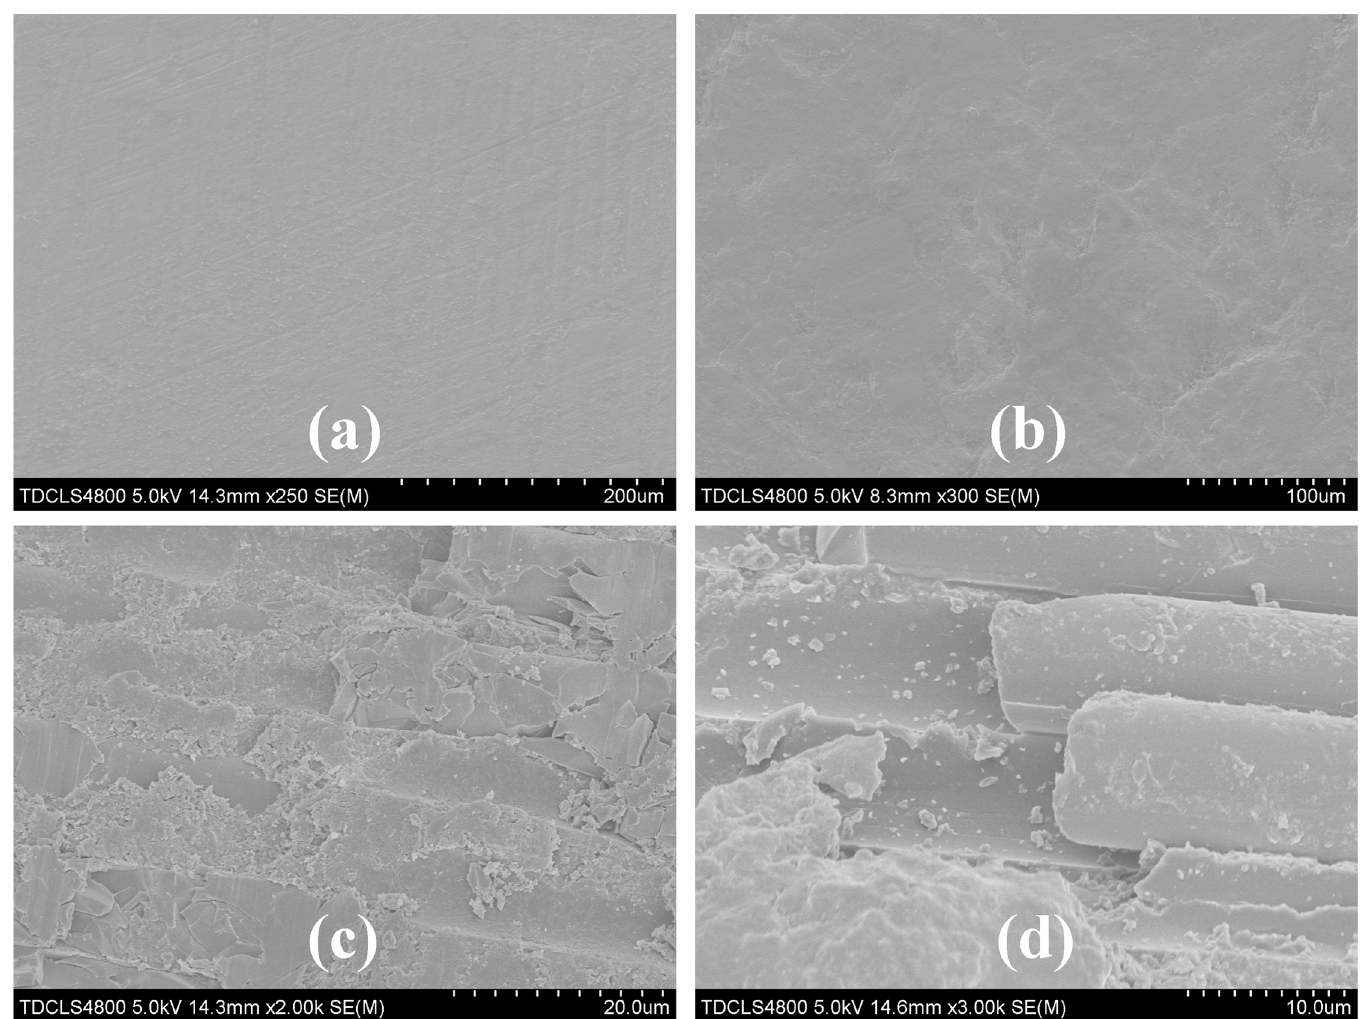
Fig 3. SEM images of the surface of the zirconia posts (a) before and (b) after sandblasting, the surface of the fiber posts (c) before and (d) after